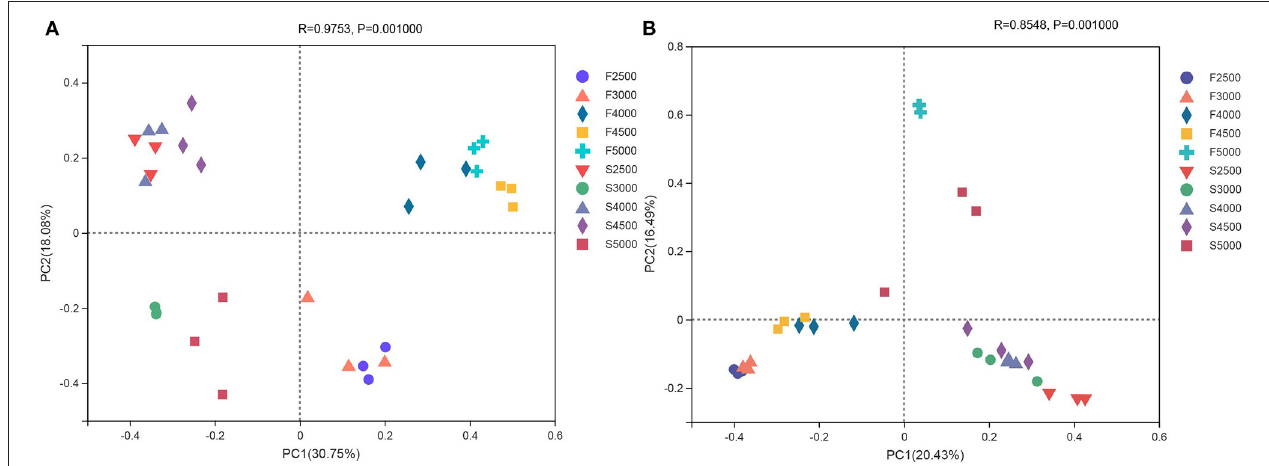
FIGURE 1 | The unweighted principal coordinate analysis (PCoA) of bacterial (A) and fungal (B) community of K. pygmaea along the elevation gradient on the Tibetan Plateau. F2500, F3000, F4000, F4500, and F5000 represent samples of fresh K. pygmaea at corresponding altitude gradients. S2500, S3000, S4000, S4500, and S5000 represent samples of K. pygmaea silages at corresponding altitude gradients. Percentage variation explained by each PCoA is indicated on the